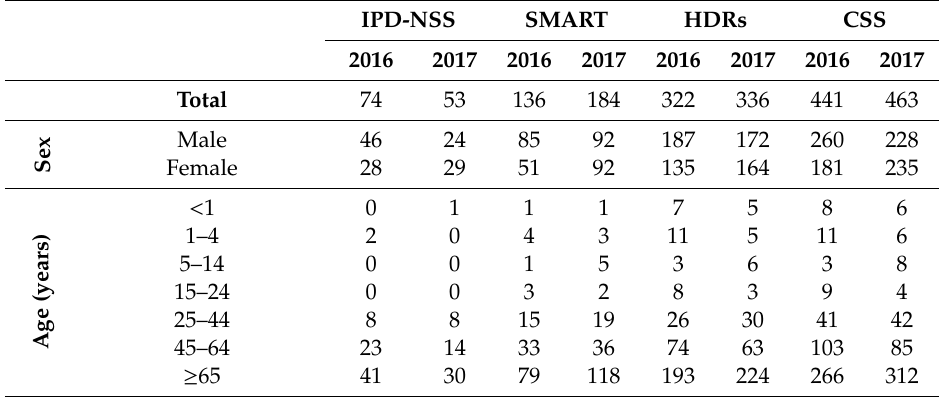
Table 1. Number of cases observed in 2016 and 2017 for each of the three sources and the combined surveillance system (CSS), including sex, age, and origin information.